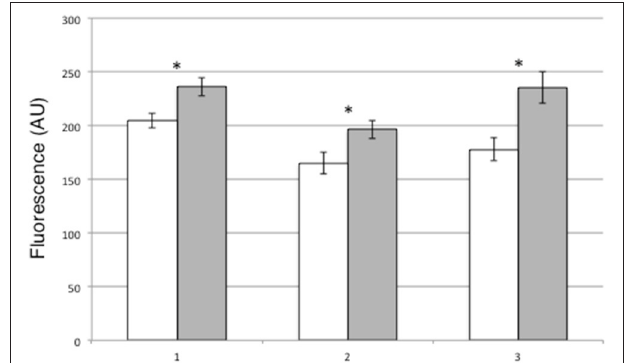
FIGURE 6 | NO production in DAF-FM loaded leaves of wild type and 8–9 leaves. DAF-FM-DA fluorescence is indicated as pixel intensity arbitrary units (AU). Wild type (white bars), 8–9 over-expressing lines (gray bars). (1–3) Bars represent the average and SE for three independent experiments ( n > 85 guard cells per experiment and genotype). Asterisks indicate significant differences (1, p < 0.002; 2, p < 0.005; 3, p < 0.0001; VassarStats analysis of variance program).